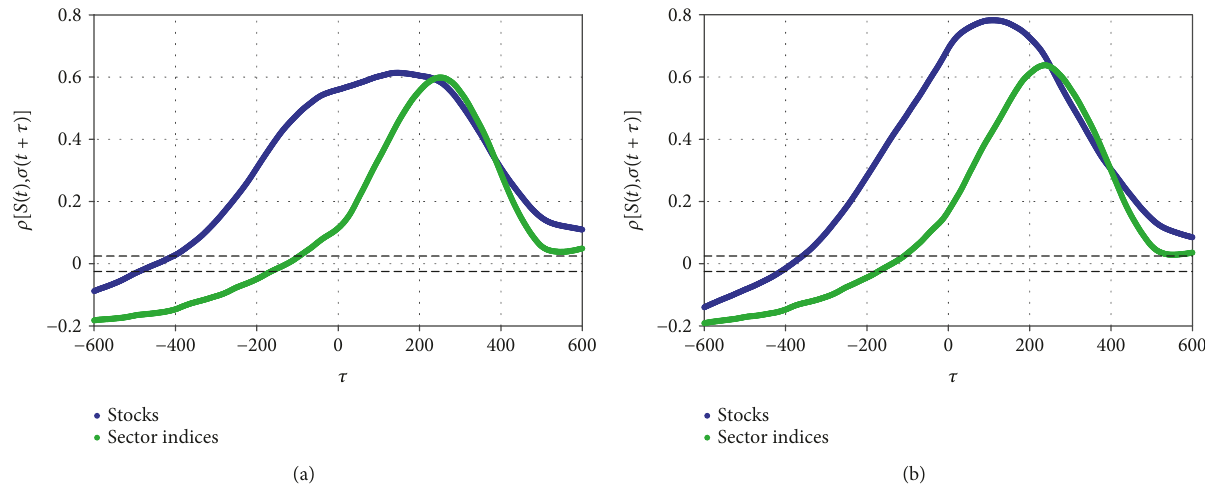
Figure 8: Cross-correlation functions between the volatility of the S&P 500 index σ t and the SCC index S t (a), and the cross-correlation function of the S&P 500 volatility and the VIX · S t indicator (b). The observed cross-correlation functions peak around τ = 150 for stocks and τ = 250 for sector index data. Table 1: Regression analysis of the developed SCC index on the future realized market volatility, using reduced (without the SCC index S ) and expanded (including S ) models: without, with, and only using the interaction term VIX ⋅ S , performed on both the U.S. stocks and U.S. sector index data. Coe ffi cients signi fi cant at the 1% signi fi cance level are marked with an asterisk ( ∗ ). The respective adjusted R 2 measures and the Akaike information criterion (AIC) are also reported — including the AIC di ff erence ( Δ ) from the null (reduced)